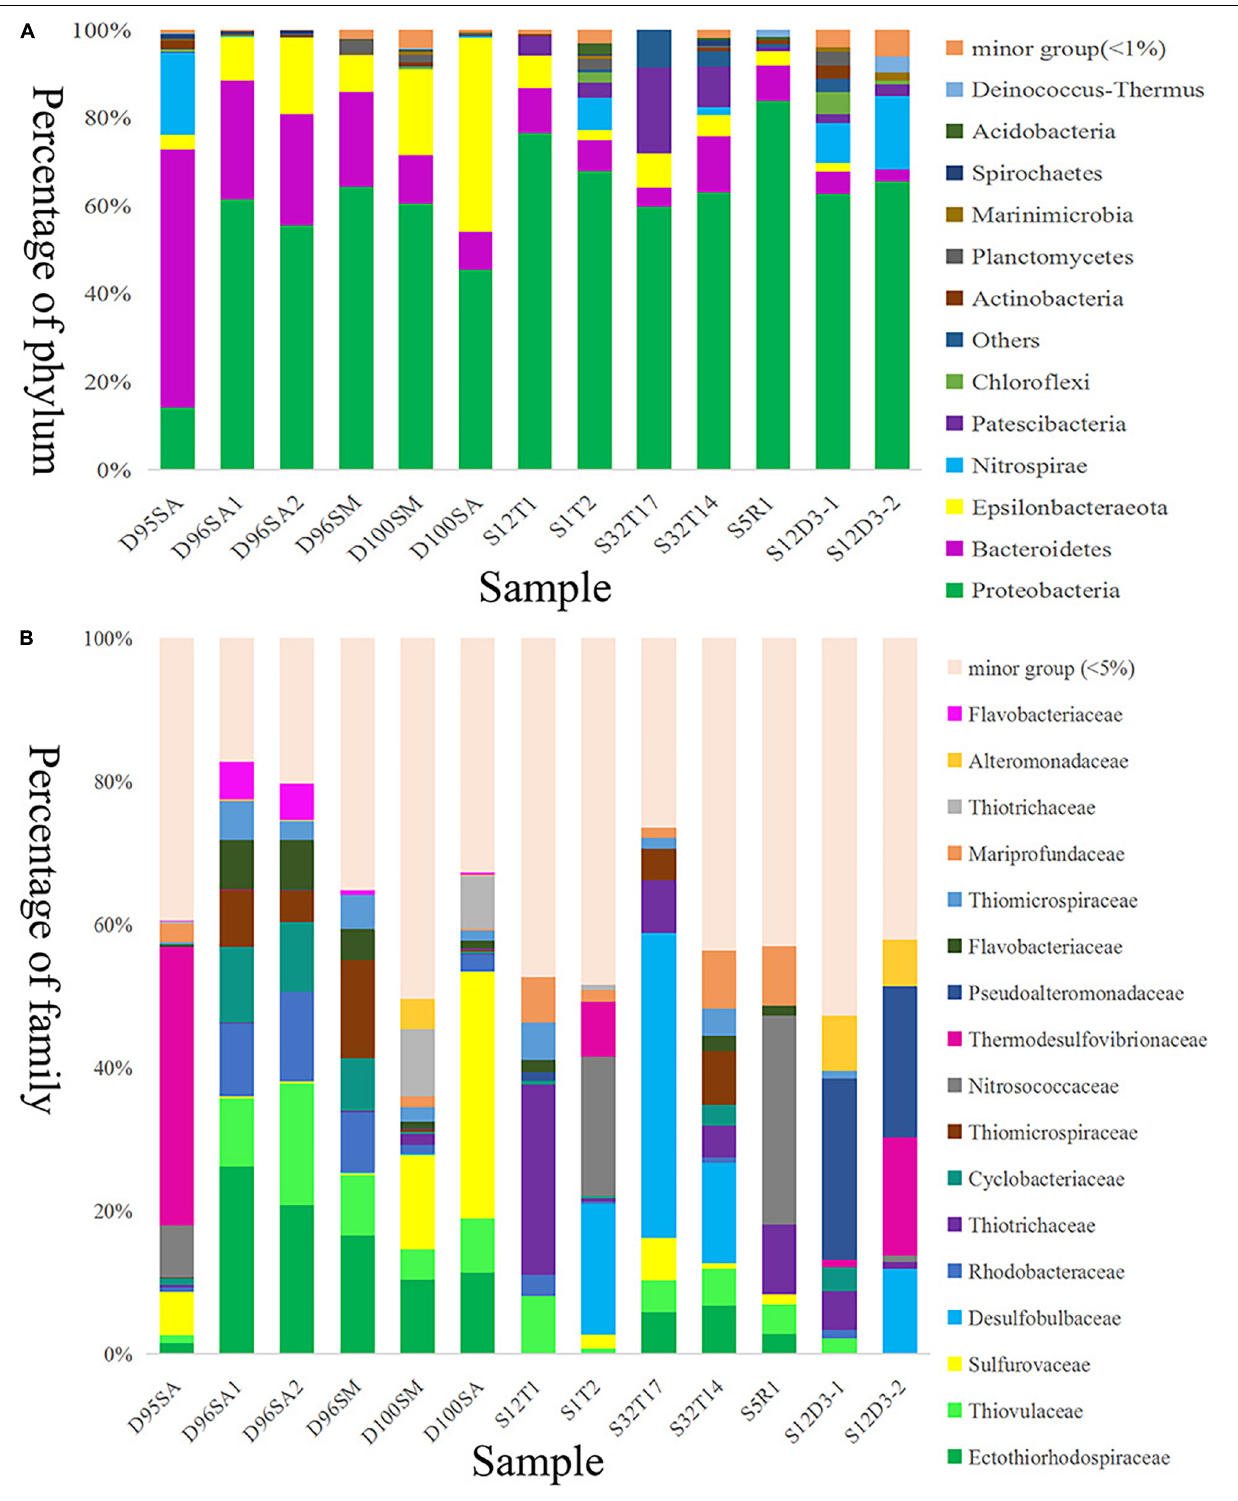
Frontiers in Microbiology |